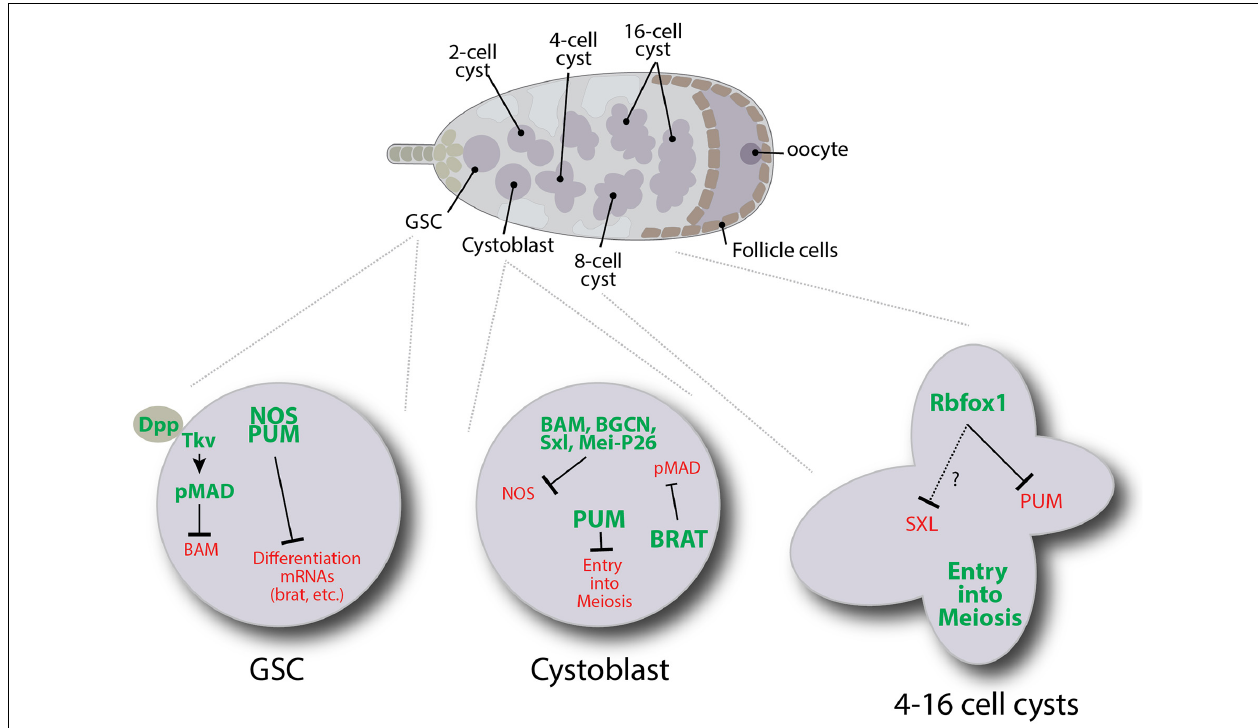
FIGURE 4 | Schematic illustrating some of the translation regulatory pathways that control specific events during the early stages of Drosophila female germ cell development.